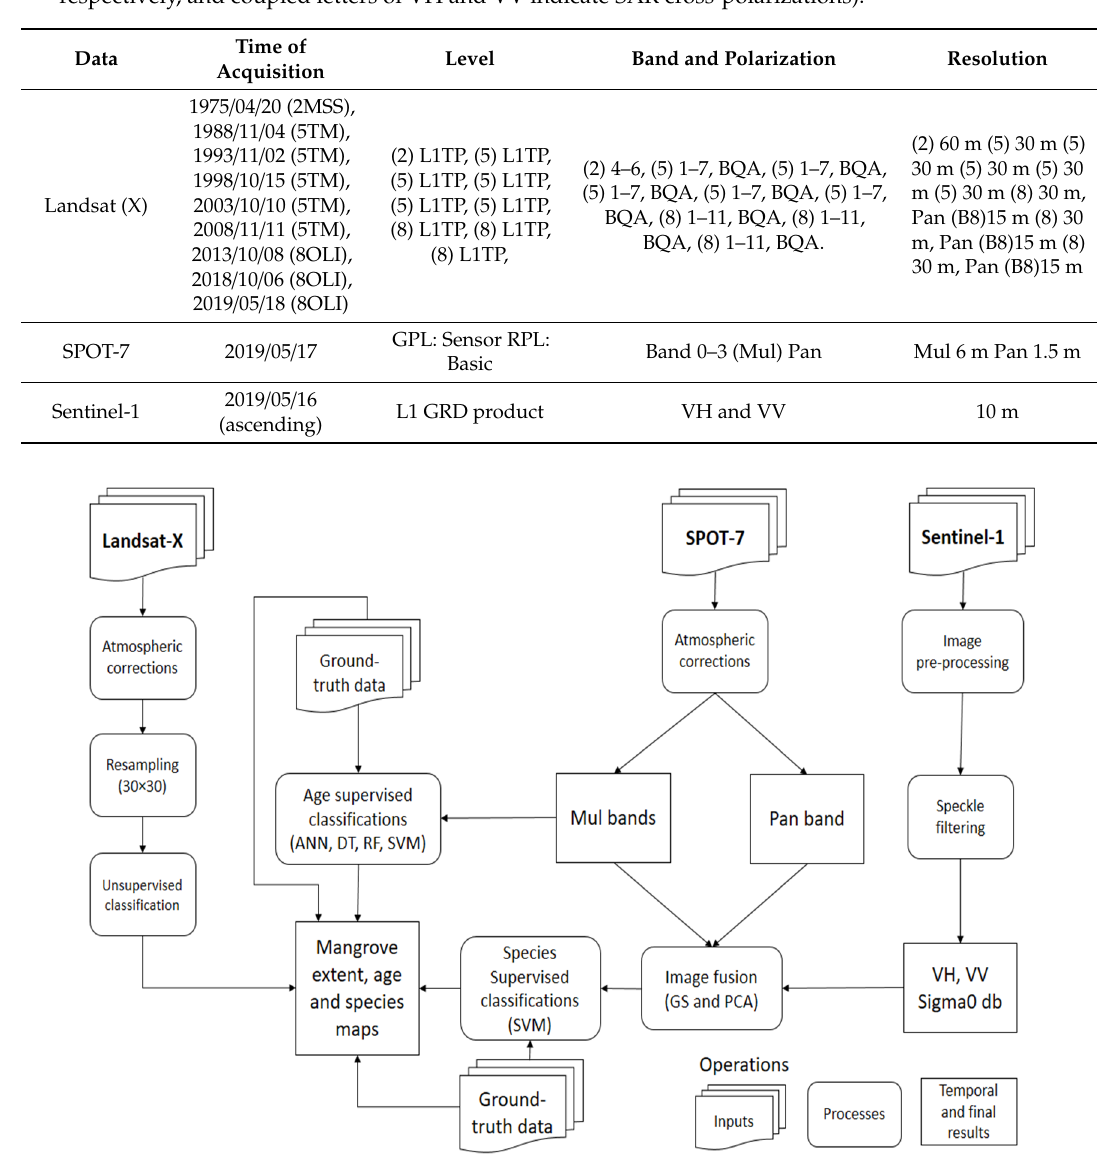
Table 2. Summary of remote sensing data used (X refers to the Landsat mission of 2, 5, and 8; L1TP is data processing level 1 with precision terrain corrected; BQA stands for band quality; MSS is Multispectral Scanner Sensor; TM stands form; OLI is Operational Land Imager; Mul and Pan are short for multispectral and panchromatic bands, respectively; GPL is geometric processing level; RPL is radiometric processing level; and GRD is ground-range detected. V and H are vertical and horizontal, respectively, and coupled letters of VH and VV indicate SAR cross-polarizations).